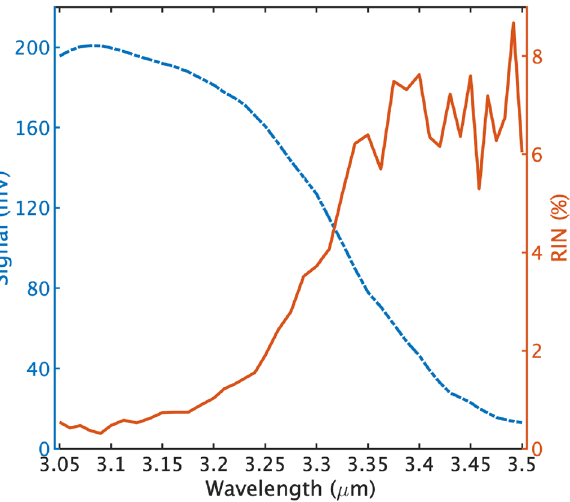
Figure 3. Measured backscattered SC spectrum (– -) from a diffuser and the corresponding relative intensity noise (—) based on ten consecutive